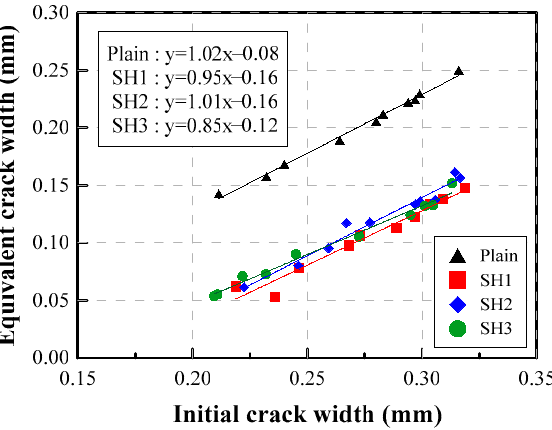
Figure 11. Relationship between the crack width at 28 days and the initial crack width.